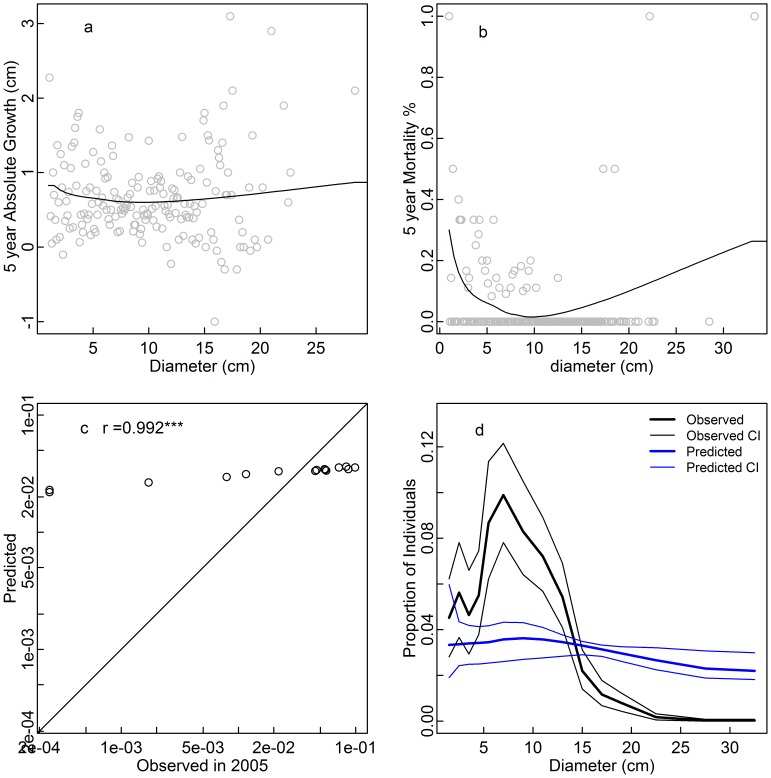
Five year absolute diameter growth (a), five year mortality rate (b), and observed 2005 vs. predicted equilibrium proportions of individuals in each size class (c,d) for Rapanea neriifolia.The prediction was derived from growth and mortality functions under the assumption that the population is at demographic equilibrium. Confidence intervals were obtained from bootstrapping over 20×20 m subplots (d).